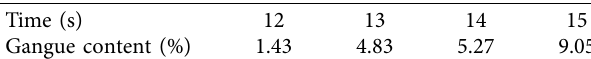
Figure 9: Calculation of gangue content by pixel number. Table 2: Gangue content of released body at diferent time